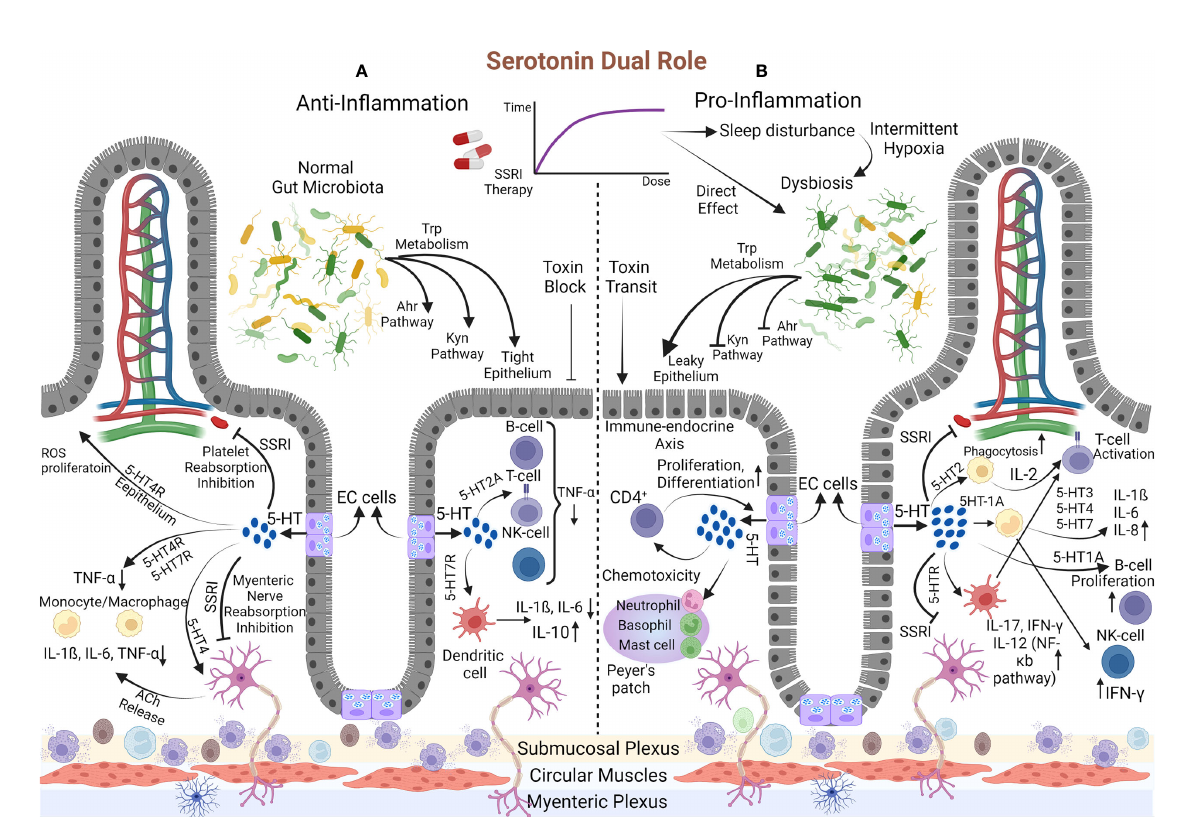
FIGURE 3 The dual demeanor of Serotonin. (A) Anti-In fl ammatory: The gut microbiota enter the Trp into Ahr and Kyn pathways and the 5-HT synthesis process. Initially, SSRIs inhibit 5-HT reabsorption in platelets and myenteric nerves and boost mucosal serotonin content, initiating anti- in fl ammatory mechanisms. Proliferation and resistance to ROS arise in the epithelium via the 5-HT4 receptor. 5-HT reduces TNF- a production by monocytes and macrophages (1) directly through their 5-HT4 and 5-HT7 receptors and (2) indirectly via the 5-HT4 receptor on the myenteric nerve, which is accompanied by releasing Ach that eventually comes up with IL-1ß, IL-6, and TNF- a decrement. Similar changes in TNF- a fabrication occur via B-cell, T-cell, and NK cell 5-HT2 receptors. Additionally, 5-HT7 on the DC turns down the IL-6 and IL-1ß and elevates IL-10. (B) Pro-in fl ammatory: Over time, SSRI dosage augmentation affects, directly and indirectly, the gut microbiota composition, and disrupts Ahr and Kyn pathways. Pathogens ’ toxins pass the leaky epithelium created by dysbiosis and stimulate the gut toward in fl